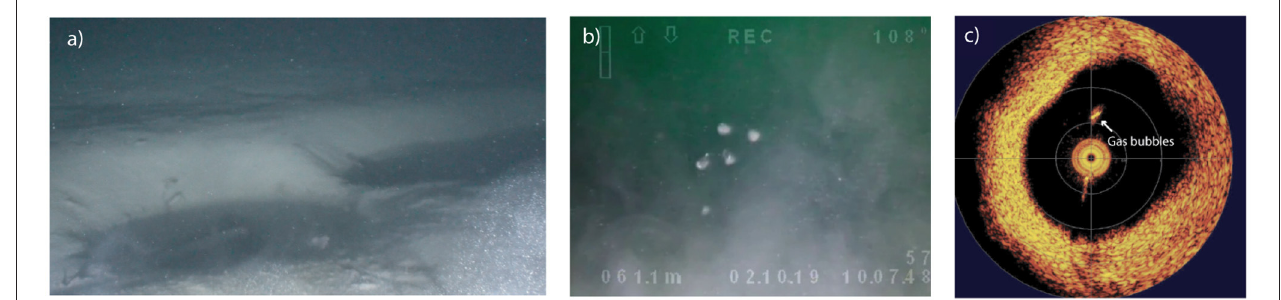
FIGURE 4 | Selection of images of the DPS. Using the ROV, we cruised around the pockmark site (17m south from the pockmark) that consists of a field of numerous smaller pockmarks than those observed on the bathymetric map ( Figure 2 ). (a) Picture of pockmarks located in the area. (b) Gas bubbling in bottom waters coming directly from some of these pockmarks. (c) Sonar picture taken during the ROV descent showing gas bubbles in bottom waters above pockmarks. The picture shows the amplitude in dB where the yellow color represents high amplitude (e.g., reflection) while the orange toward black one show low amplitude sound echoes,